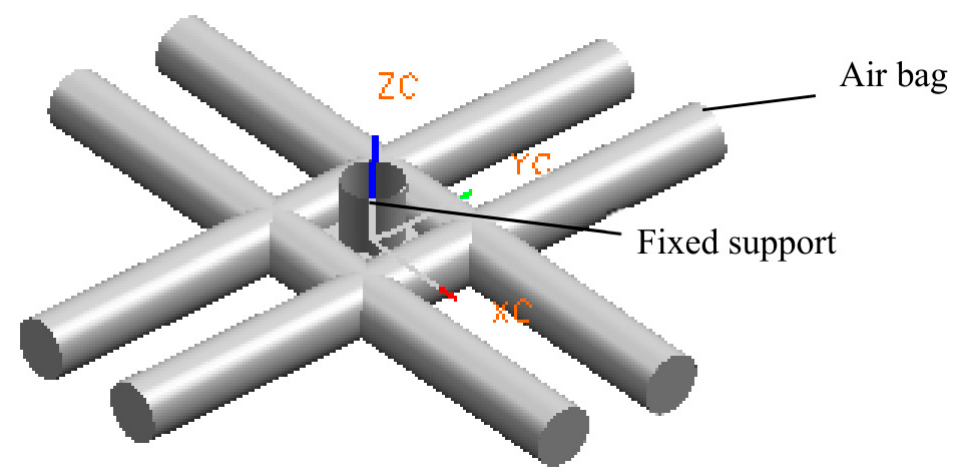
Figure 2. Structure diagram of the floating platform.